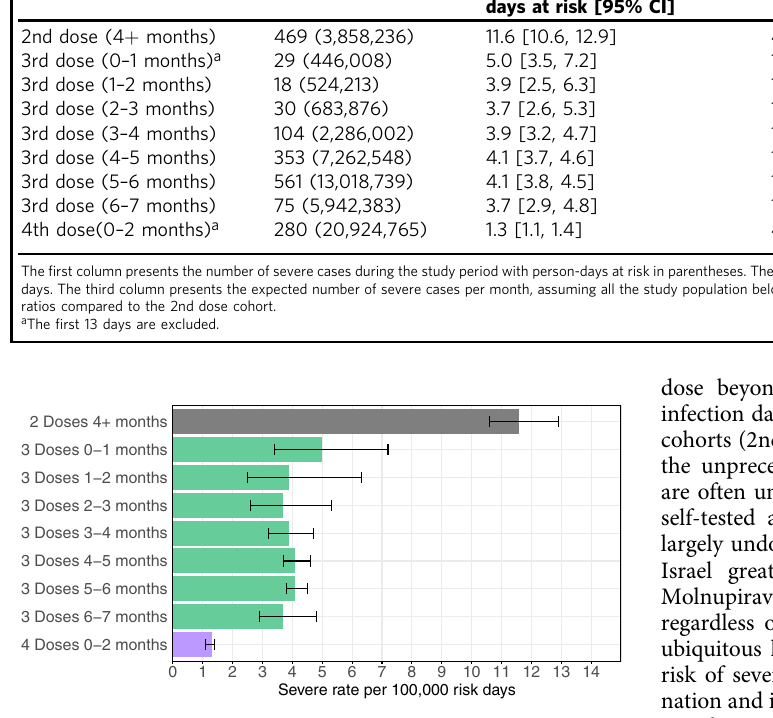
Table 2 Results of the Poisson regression analysis for severe disease. Group (days from